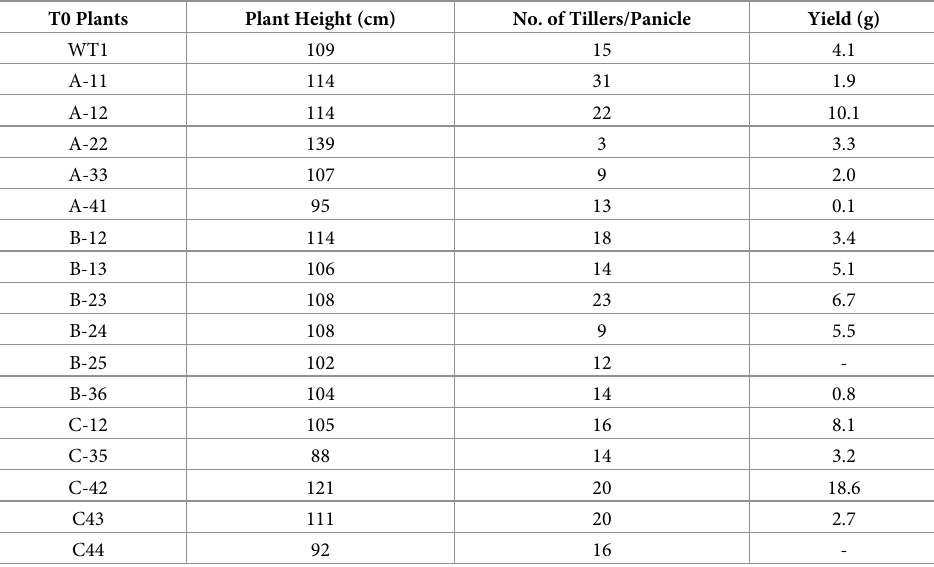
Table 2. Morphological characterization of T0 transgenic progeny